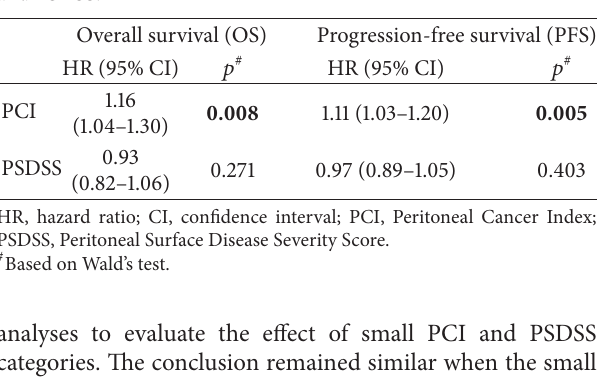
Table 4: Multivariate Cox-regression analysis of OS and PFS by PCI and